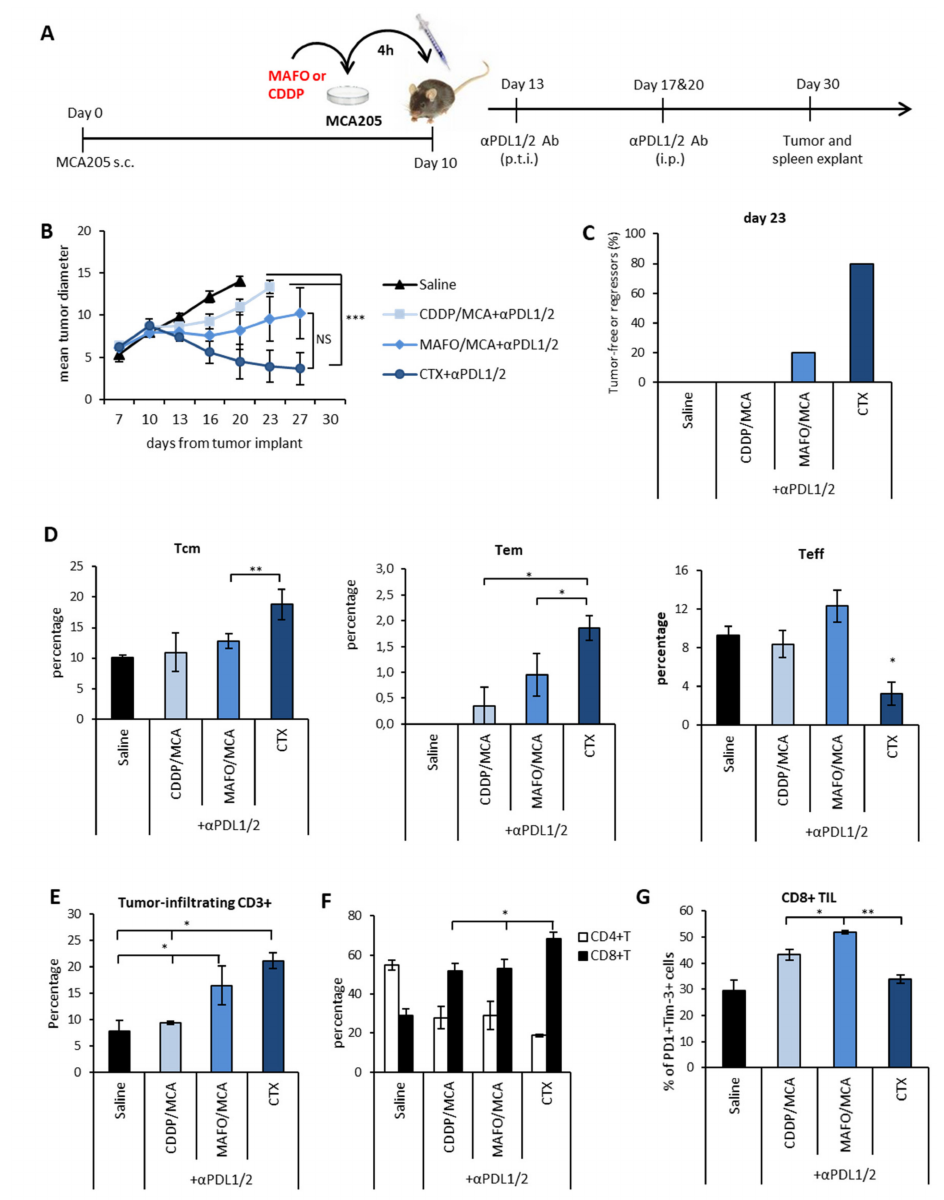
Figure 6. Vaccine-like e ff ect of chemotherapy was necessary, but not su ffi cient for synergism with PDL blockade. (A) Schematic representation of the experimental design. MCA205 tumor cells were forced to die by in vitro incubation with either CDDP or MAFO for 4 h, then washed and injected s.c. at the tumor site followed by three anti-PDL1 / 2 injections as indicated. (B) Mean tumor size ± SEM in mice treated with the indicated treatments ( n = 5). (C) Percentage of tumor-free or regressing tumors in each experimental group on day 23 from treatment initiation. One representative experiment out of two with similar results is shown. (D) Frequency of central memory (Tcm), e ff ector memory (Tem) and e ff ector (Te ff ) CD3 + CD8 + lymphocytes in spleens 20 days after treatment initiation ( n = 5). (E) Percentage of CD3 + TIL and (F) relative abundance of CD4 + and CD8 + TIL ( n = 5). (G) Expression of PD1 and Tim-3 on CD3 + CD8 + TIL. Data are expressed as mean percentage ± SEM ( n = 5). * p < 0.05; ** p < 0.01; *** p < 0.005. NS =